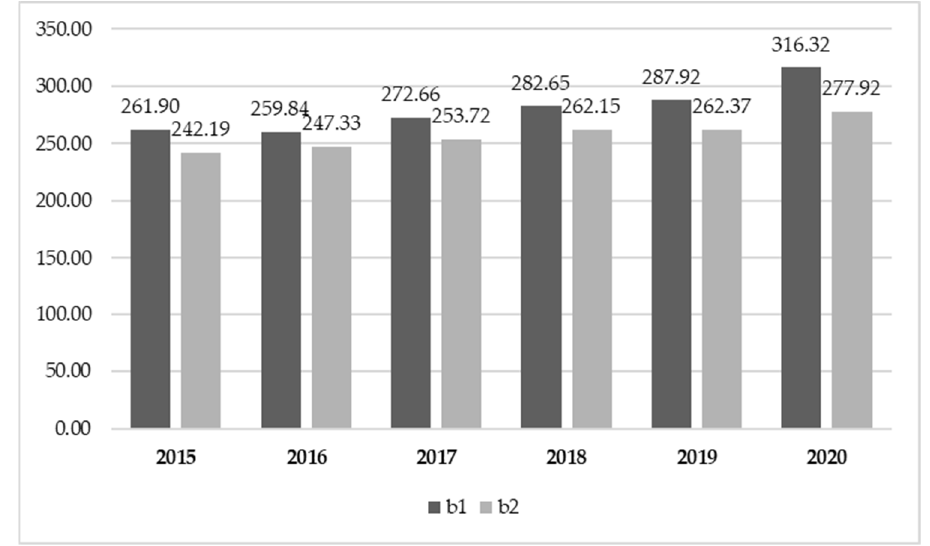
Figure 4. Wine sales trend in value on the Italian MMR (millions of EUR).